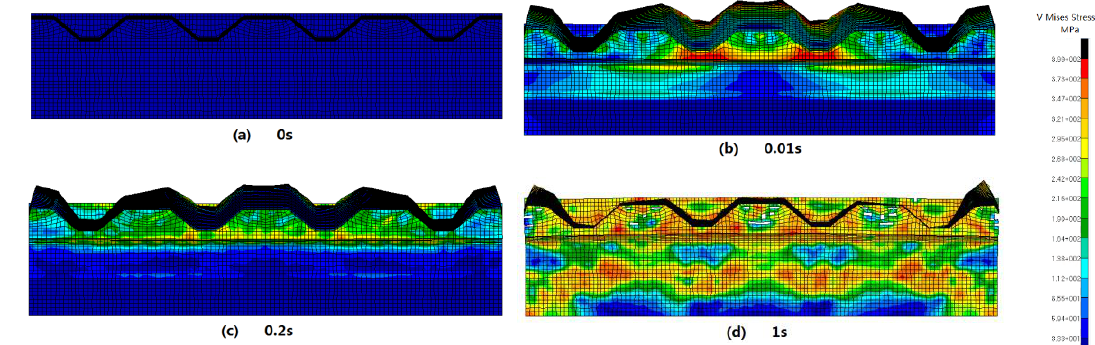
Figure 15. Stress distribution of the CBW under impulse loads. ( a ) the moment of 0 s, ( b ) the moment of 0.01 s, ( c ) the moment of 0.2 s, ( d ) the moment of 1 s.